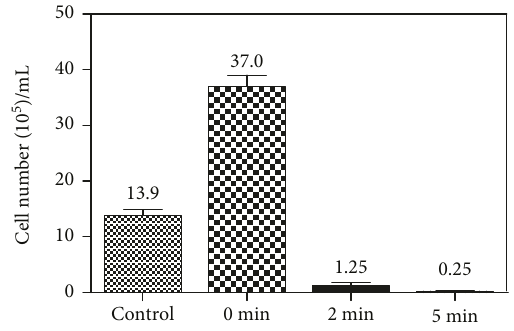
Figure 5: Chronic toxicity evaluation with algae Raphidocelis subcapitata using a combined Cl/UVC treatment containing di ff erent BPA, E2, and EE2. Initial EDC concentrations: 100 g · L -1 , initial chlorine concentration=2mg · L -1 , UVC irradiance=14.79mW cm -2 , reaction